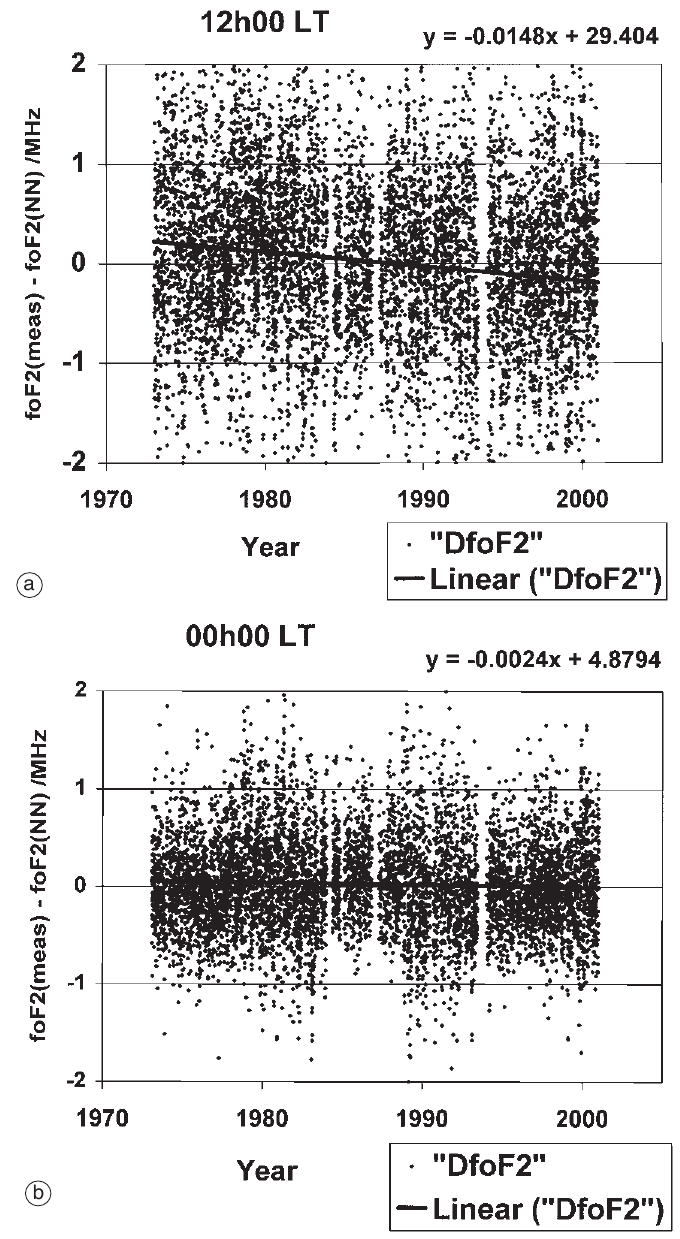
Fig. 1a,b. The residual R plotted as a function of time for HR = a) 12 h 00 and b) 00 h 00, each with a fitted linear regression